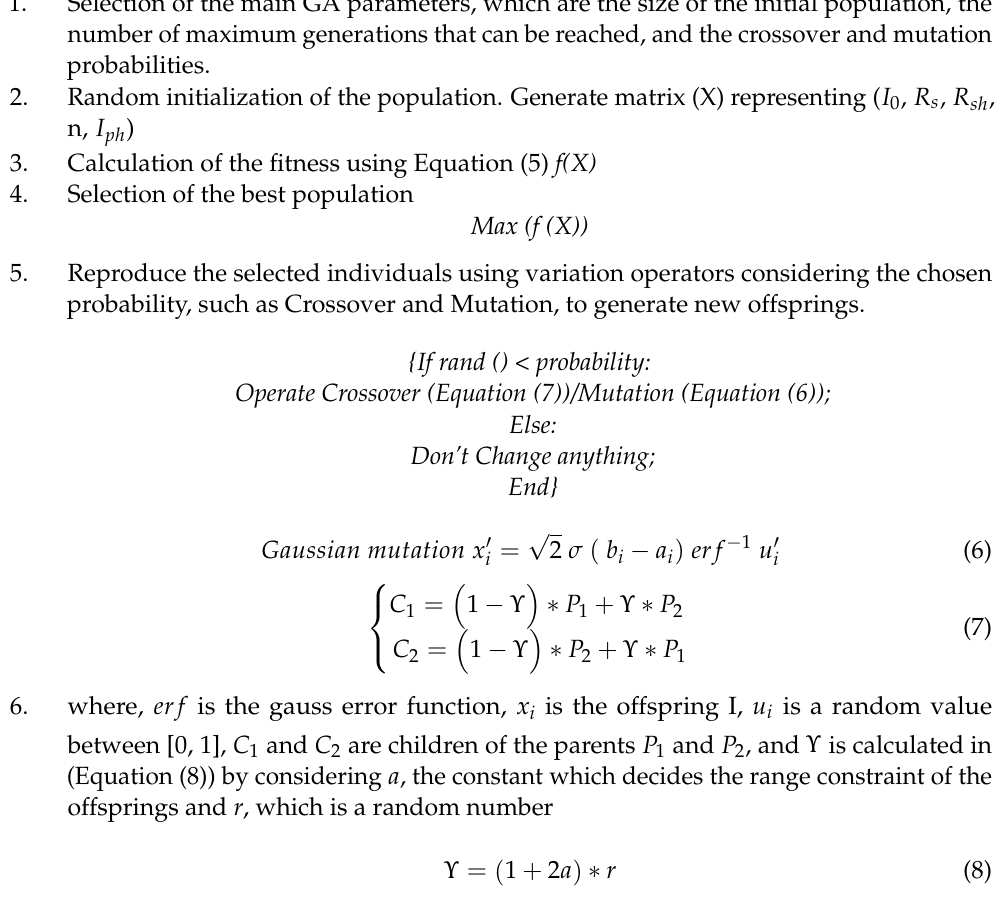
Figure 5. The shunt current diagram.